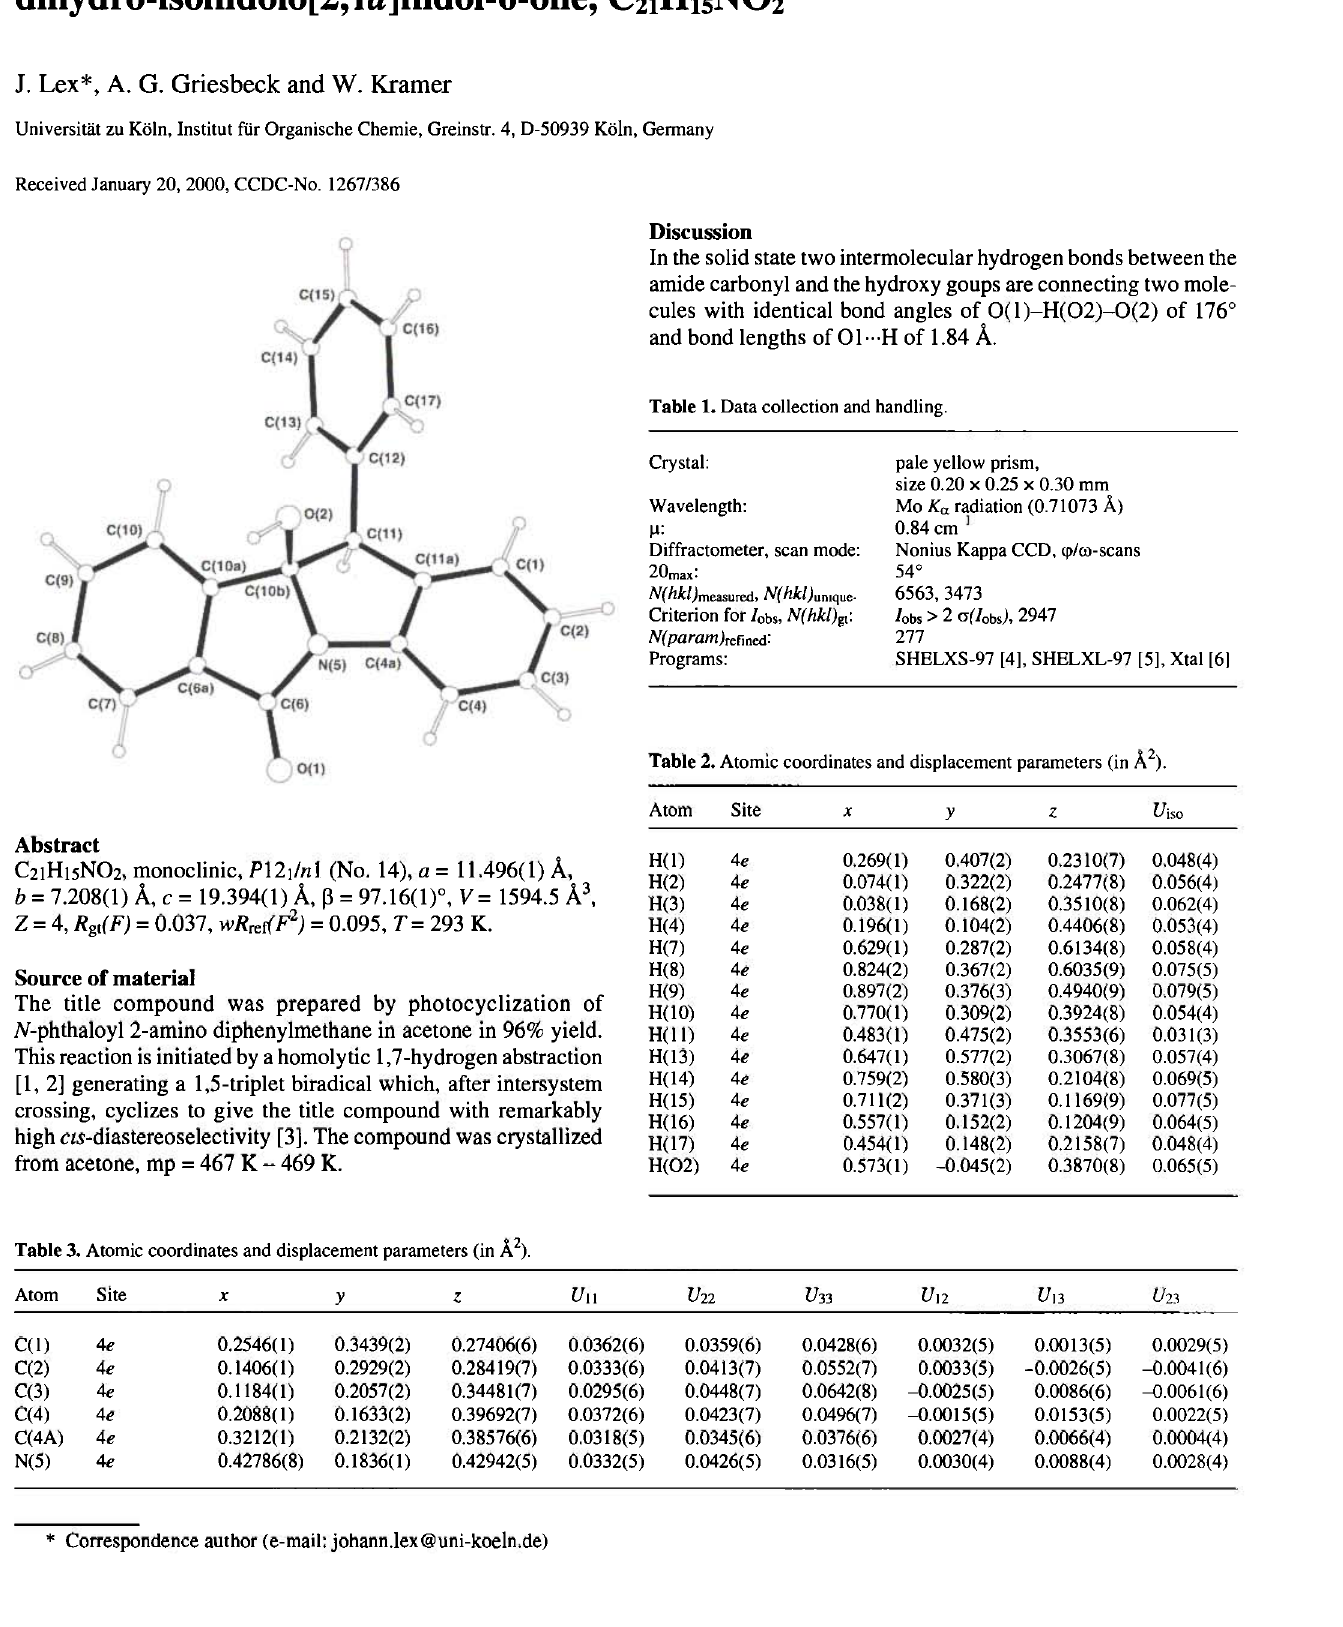
Table 3. Atomic coordinates and displacement parameters (in Ä 2